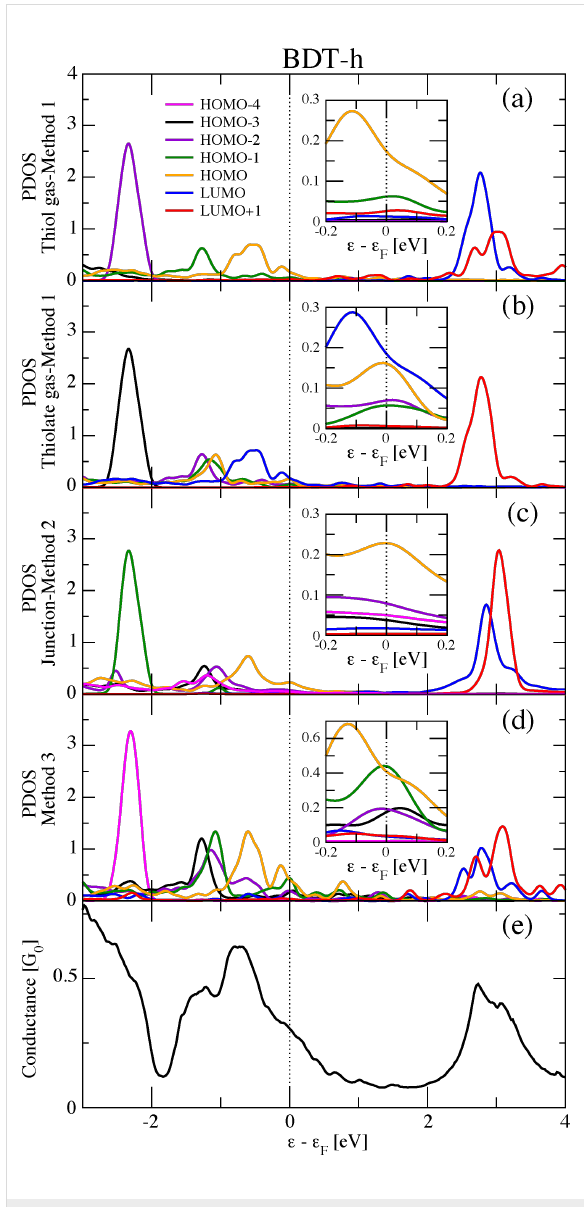
Figure 7: Projected density of states (a,b,c,d) and conductance (e) of benzene-dithiol in the hollow geometry (BDT-h). The PDOS for the different molecular orbitals (from HOMO − 3 to LUMO+1) have been obtained with (a) Method 1 based on the dithiol molecule, (b) Method 1 based on the dithiolate molecule, (c) Method 2, and (d) Method 3 (see text). The insets show the details in the Fermi energy region.